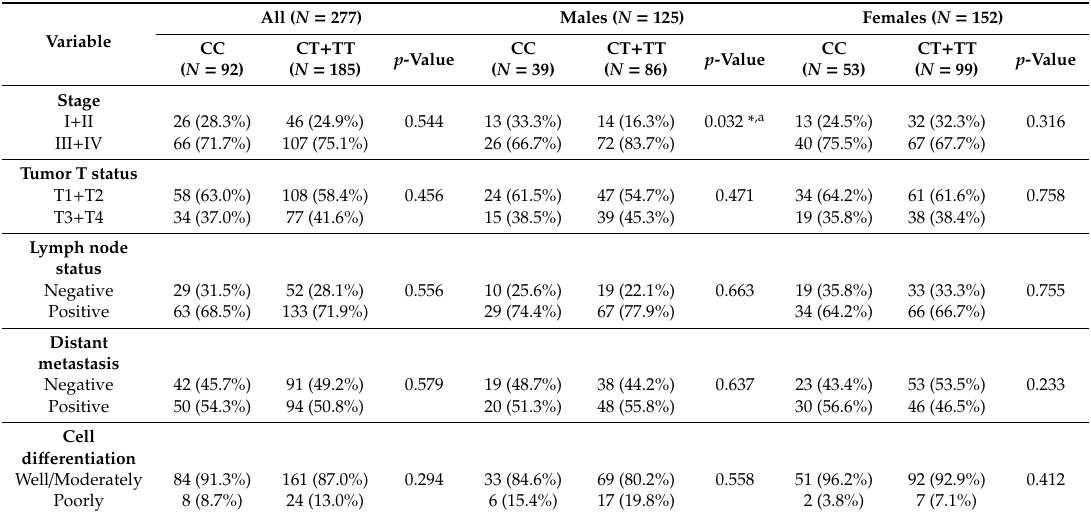
Table 5. Clinicopathologic characteristics of lung adenocarcinoma patients, stratified by polymorphic genotypes of tissue inhibitor of metalloproteinases (TIMP)-3 rs9862.